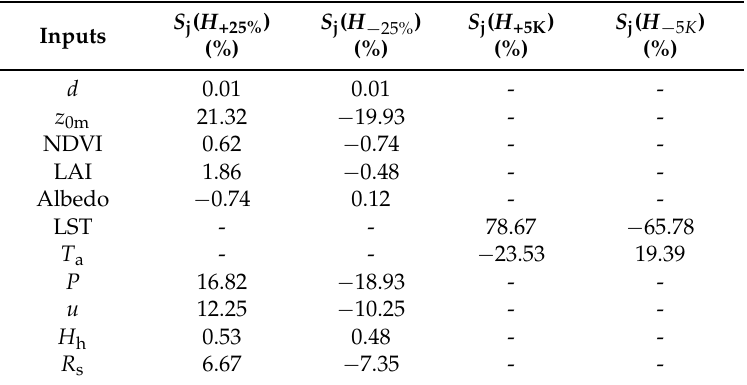
Table 1. The sensitivities of sensible heat flux ( H ) using different SEBS input parameters as a fraction of their reference